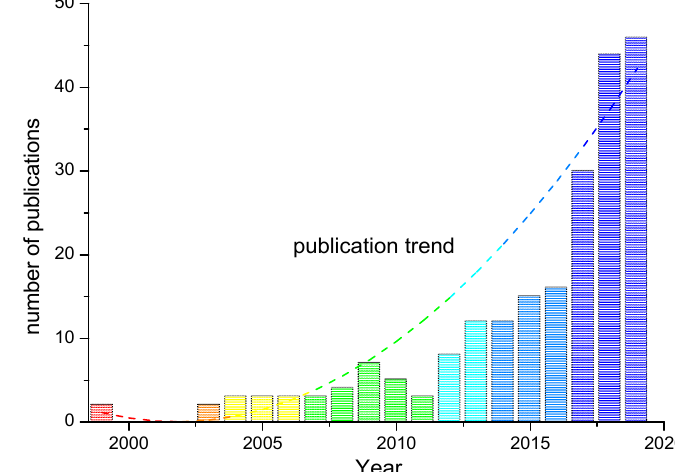
Figure 1. Number of publications per year with a trend line.